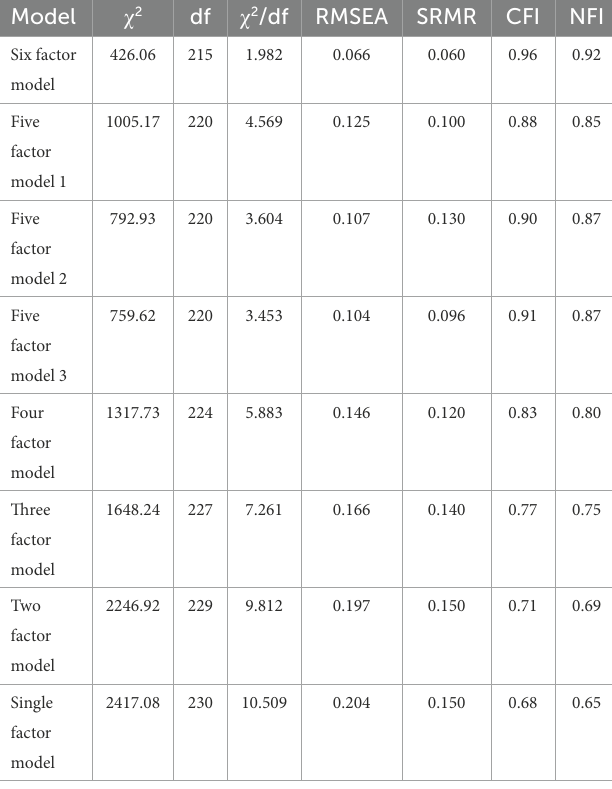
TABLE 2 Discriminative validity test.